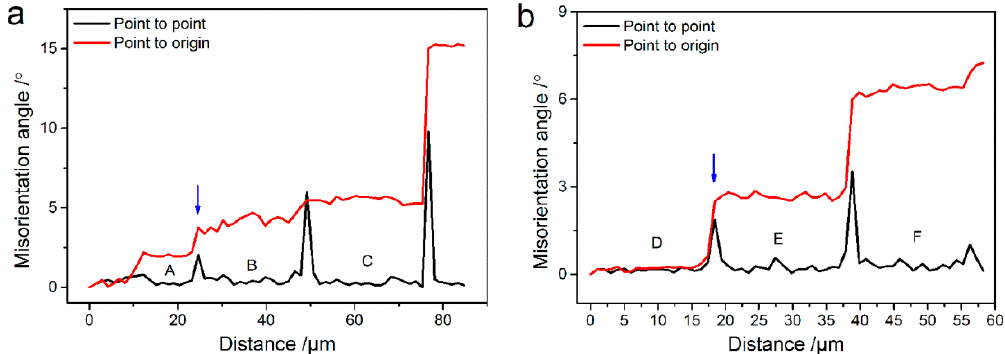
Figure 9. Misorientation profiles obtained along the lines marked in Figure 6c. ( a ) L5; ( b )